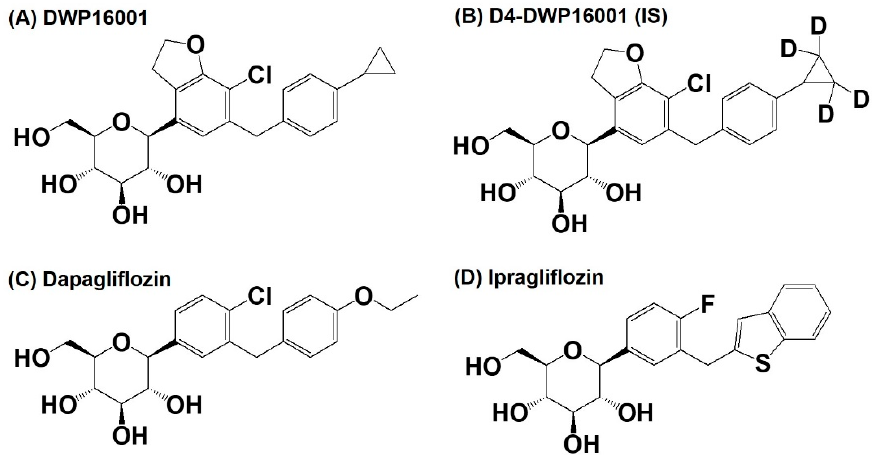
Figure 1. Structure of ( A ) DWP16001, ( B ) D4-DWP16001 (IS), ( C ) dapagliflozin, and ( D ) ipragliflozin.